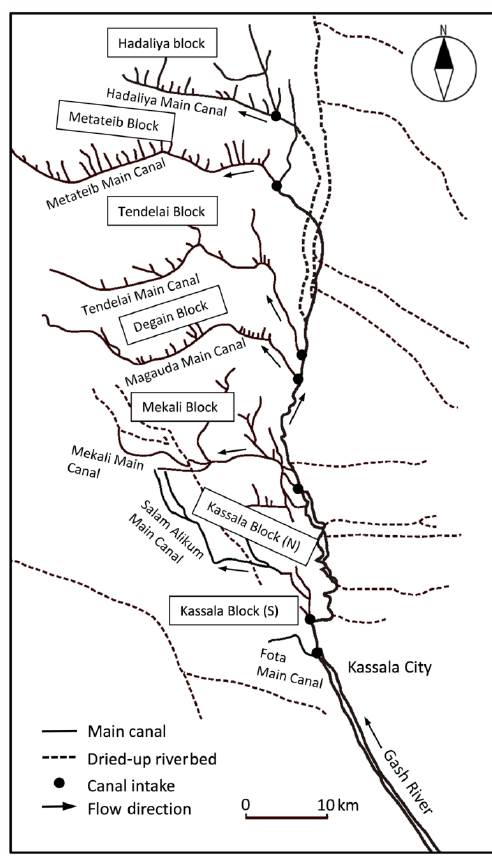
Figure 2. Schematics of the Gash Delta Spate Irrigation System (the original figure by Kirkby, 2001, was